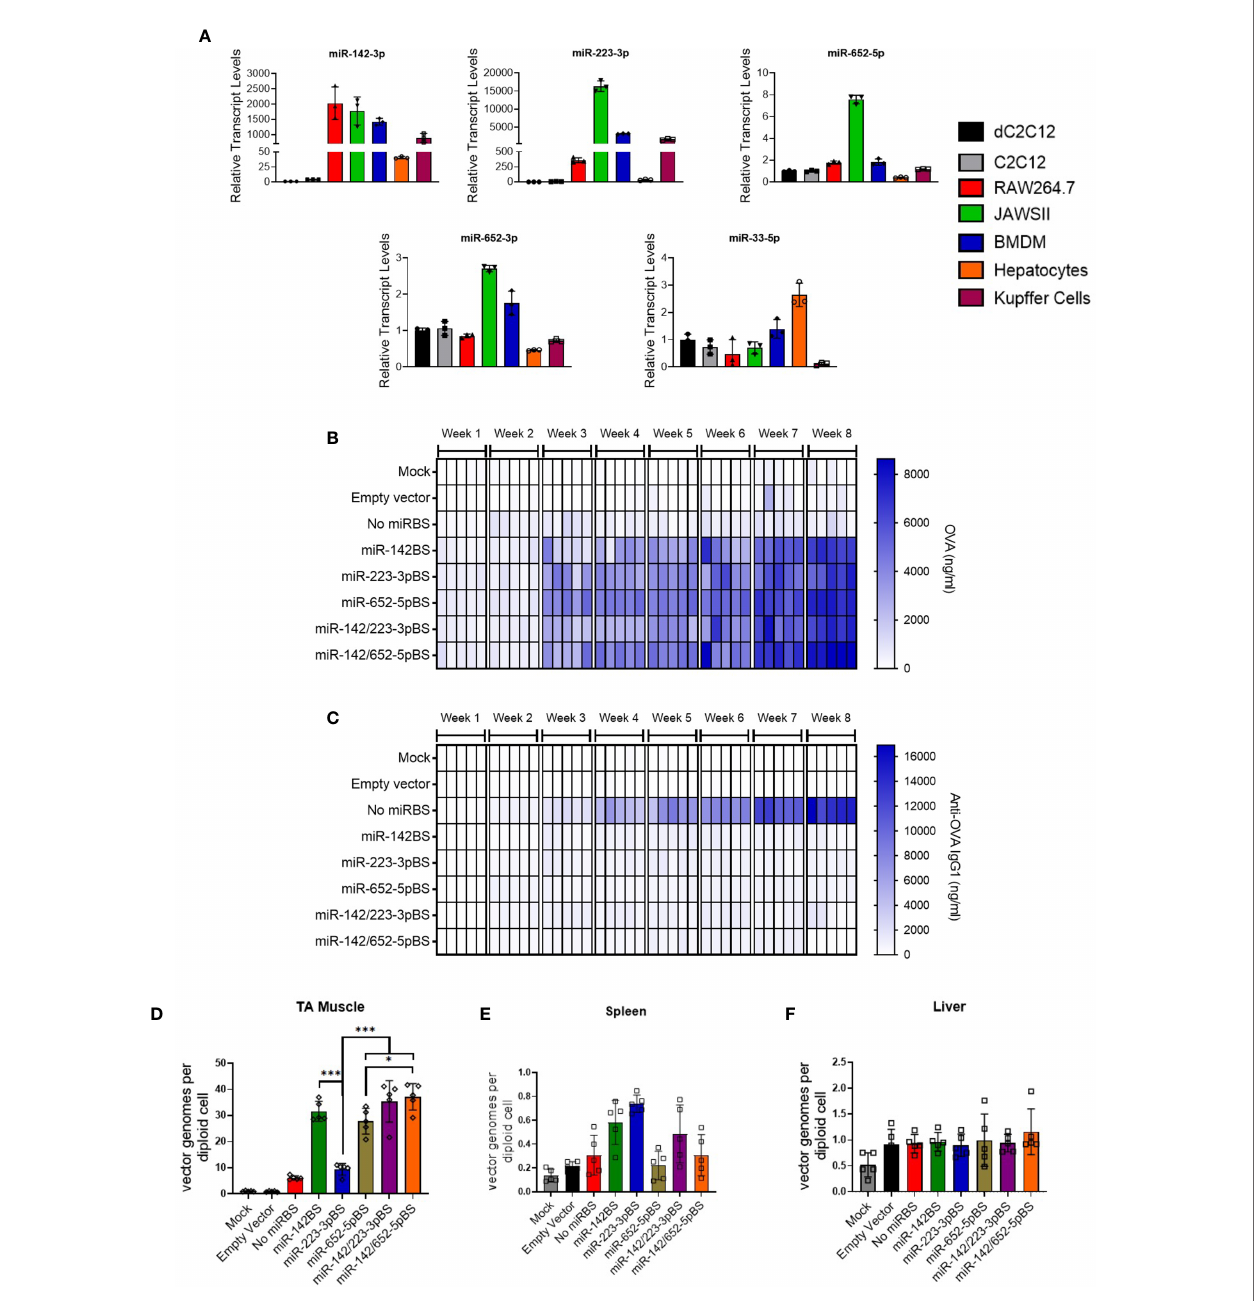
FIGURE 2 | Incorporation of miR-223BSs and miR-652BSs boosts in vivo OVA production and suppresses antibody development. (A) Endogenous miRNA expression levels in cultured mouse myoblasts (C2C12), myocytes (dC2C12), macrophages (RAW264.7), DCs (JAWSII), bone marrow derived macrophages (BMDM), primary mouse hepatocytes, and Kupffer cells as quanti fi ed by reverse transcription quantitative PCR (RT-qPCR) (n = 3). rAAV1 expression vectors were injected by i.m. on day 0 followed by serum collection every week for an eight-week period. (B , C) ELISA quanti fi cation of circulating OVA expression (B) and anti- OVA IgG1 (C) (1 × 10 11 GCs/mouse, n = 10). Single gradient heat map representing respective analyte levels ( n = 5). (D – F) ddPCR detection of rAAV vector genome copies in injected skeletal muscle (D) , spleen (E) , and liver (F) at eight weeks post-injection ( n = 5). Values represent mean ±SD. * p < 0.05, *** p < 0.001, one-way ANOVA with Tukey ’ s post hoc